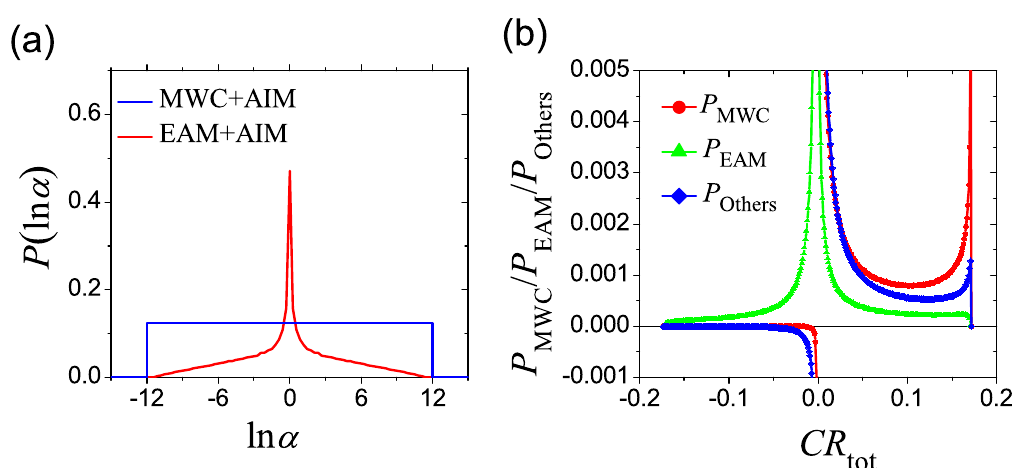
Fig 10. The properties under Ising-like interface interactions. (a) Distribution of ln α when the Ising-like interface interactions of the Allosteric Ising Model (AIM) were introduced to combine with the MWC and EAM models. The variation range of Ising interface energy is Δ G max = 3 RT. (b) The capacity of three pathways in the comprehensive ensemble model when the interface interactions are Ising-like. The variation range ( Δ G max ) for free-energy parameters is 8 kcal/mol.